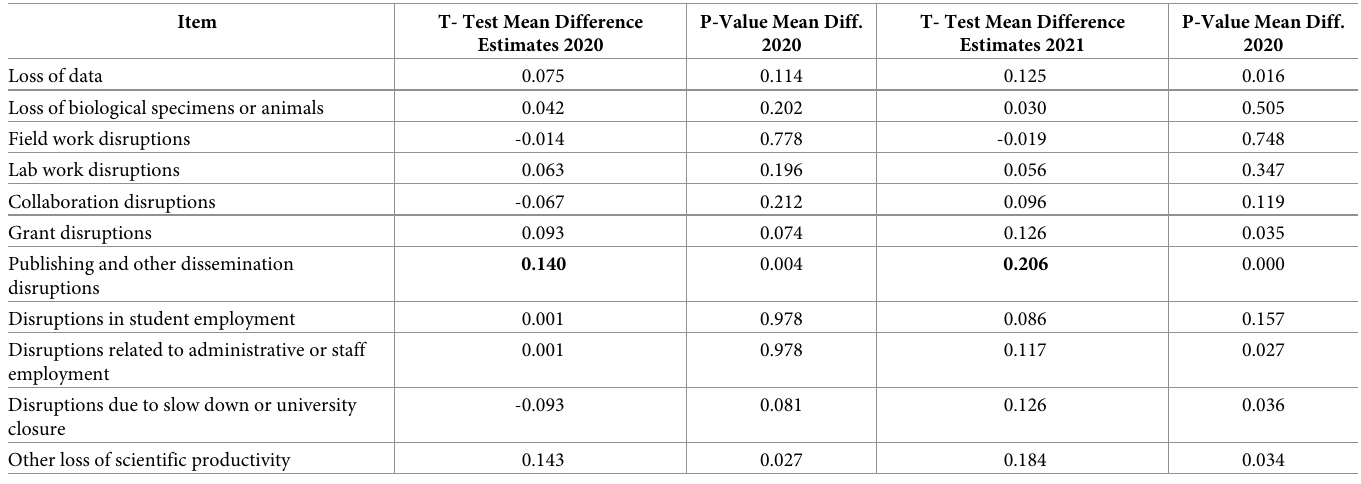
Table 1. Gender differences in 2020 and 2021 regarding the following question: Have social distancing and other COVID-19 related policies had a negative impact on your research in any of the following ways?. Item